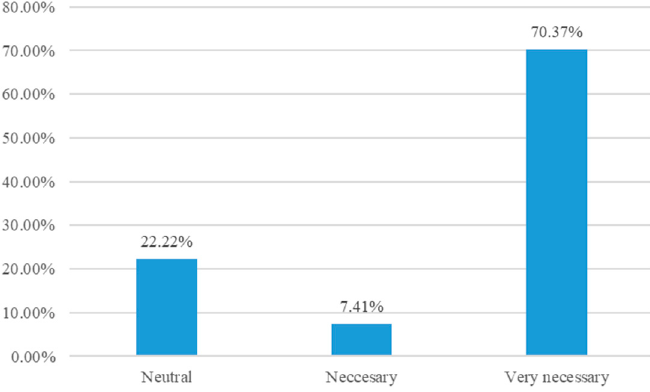
Figure 7. CICT trained by the administration.